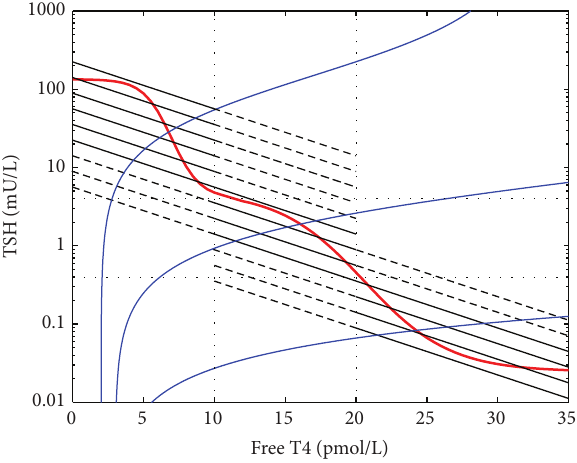
Figure 5: The generation of a population T4/TSH relationship by nonrandom associations between the physiological curves. In this example there is a hypothetical association between insensitive thyroids and sensitive pituitaries (this might occur by evolution to minimise T4 variation). The sizes of the circles, as in Figure 4, are proportionate to the number of individuals in the population with T4/TSH levels at that point. The line of best fit has a small negative slope.